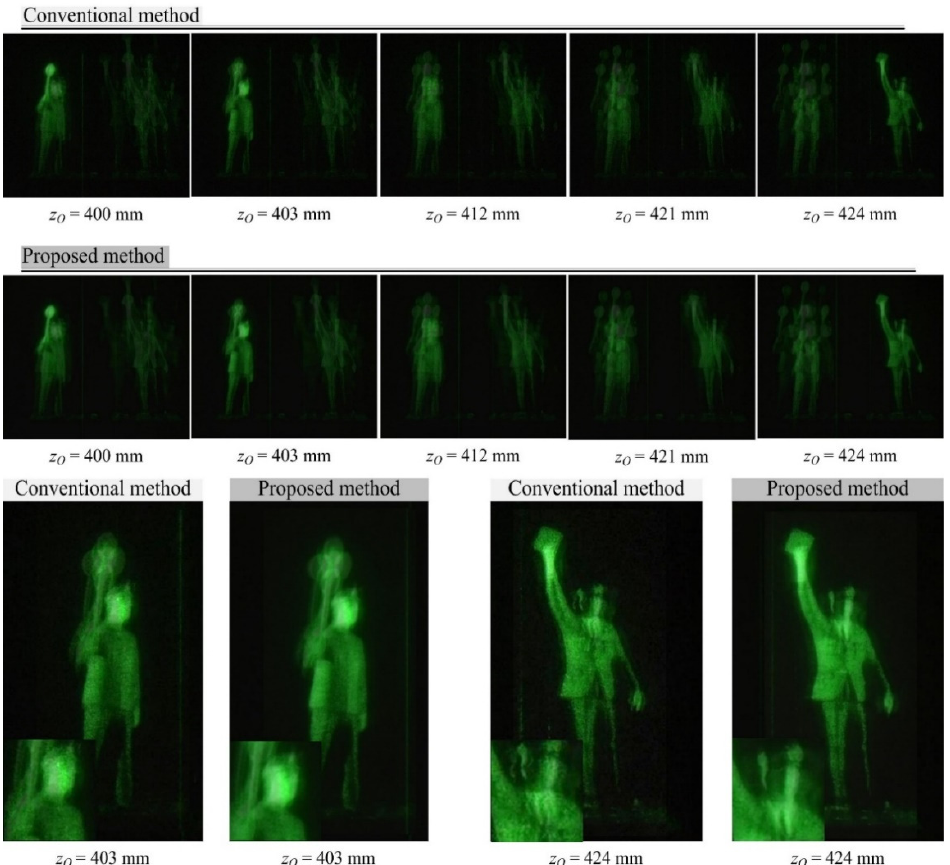
Figure 8. The 3-D computational reconstruction image by each of the conventional and proposed methods for the object in Figure 5b. The distance between the camera and the reconstruction plane is indicated at the bottom of each reconstructed image. At the bottom, zoomed images are displayed with normalized intensity.